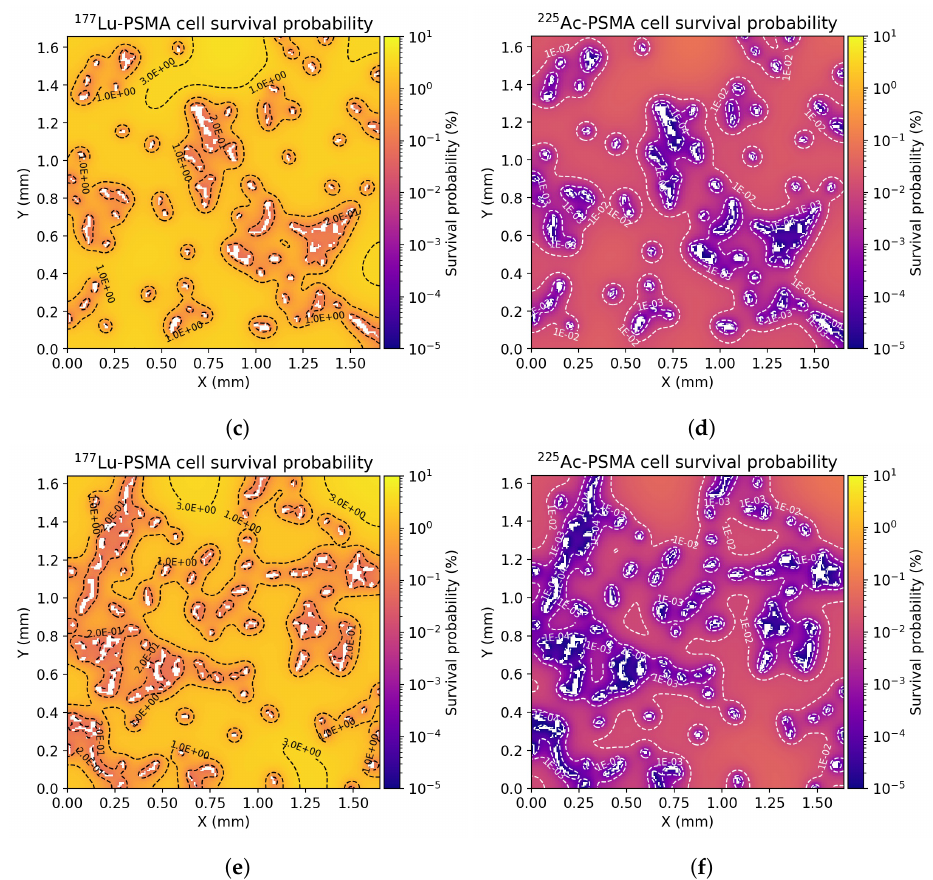
Figure 6. ( a , c , e ) 2D distribution of cell survival probabilities in ROI A, ROI B and ROI C, respectively, within each tissue segment with 177 Lu-PSMA treatment at twenty days post-injection. ( b , d , f ) 2D distribution of cell survival probabilities in ROI A, ROI B and ROI C, respectively, within each tissue segment with 225 Ac-PSMA treatment at twenty days